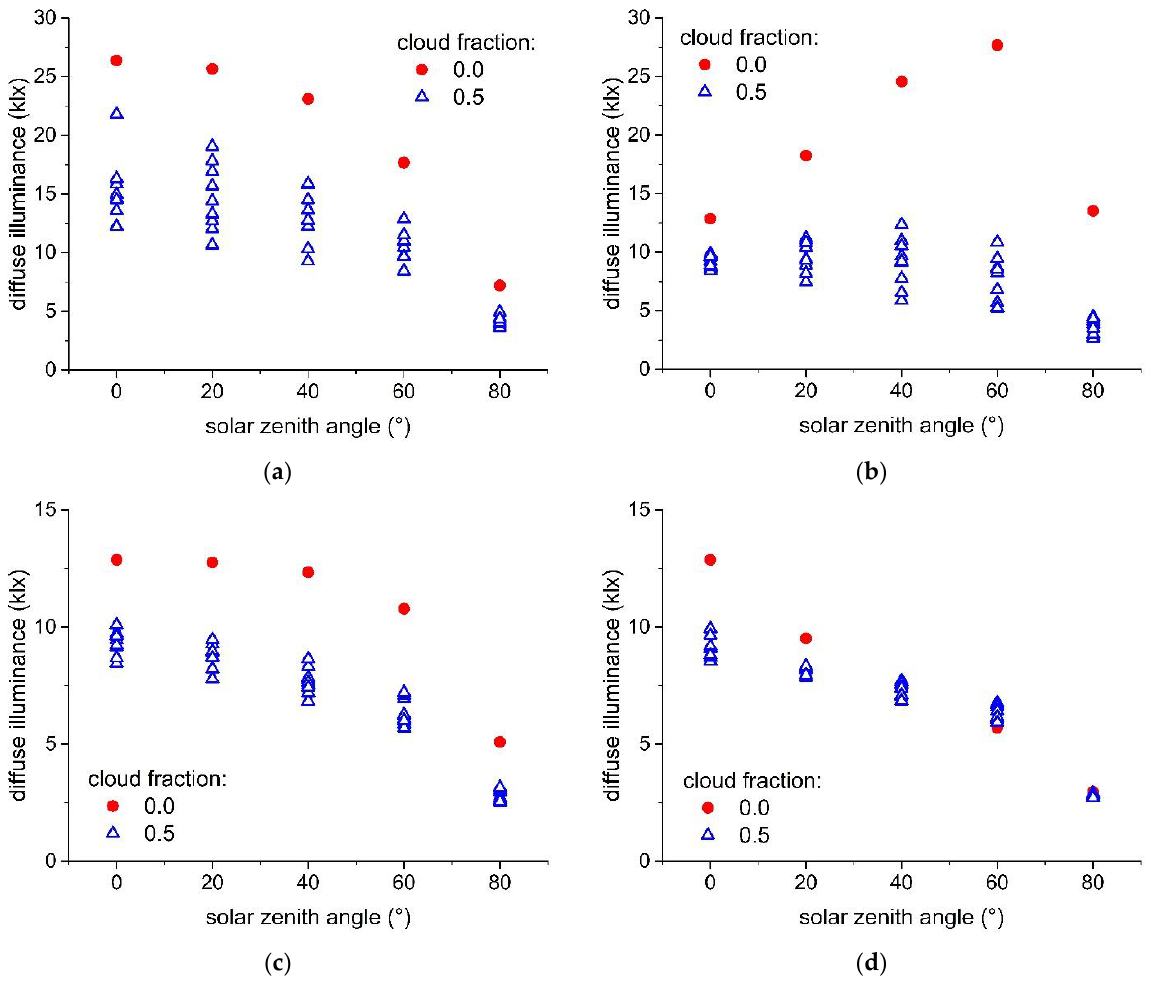
Figure 3. Diffuse illuminance on the horizontal plane ( a ) and vertical planes oriented to the south ( b ), east ( c ), and north ( d ) as a function of the solar zenith angle calculated for ten random distributions of identical clouds with the cloud fraction equal to 0.5.